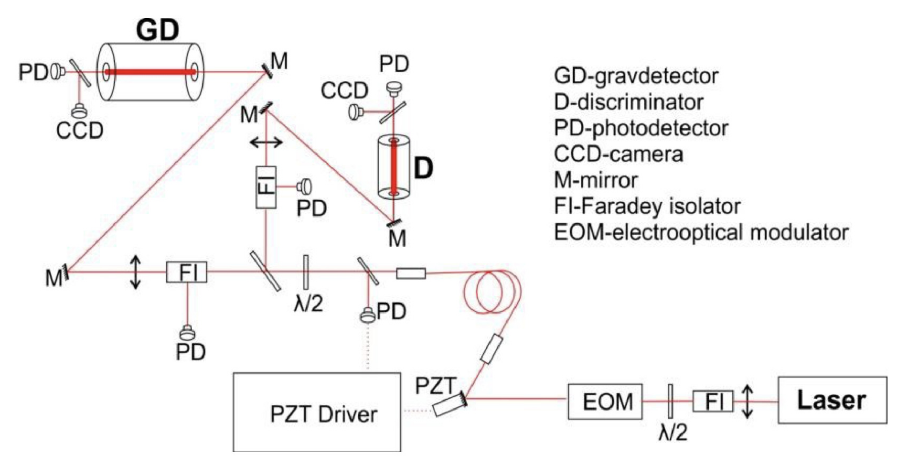
Figure 1. Principle scheme of the OGRAN antenna.